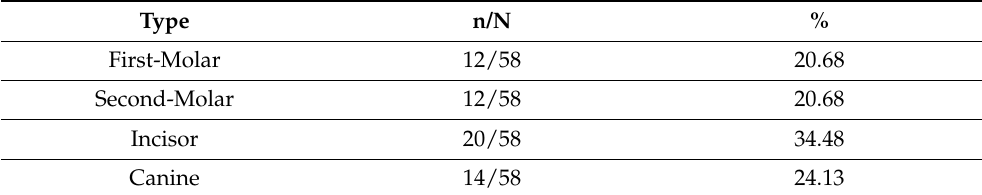
Table 1. Restorations